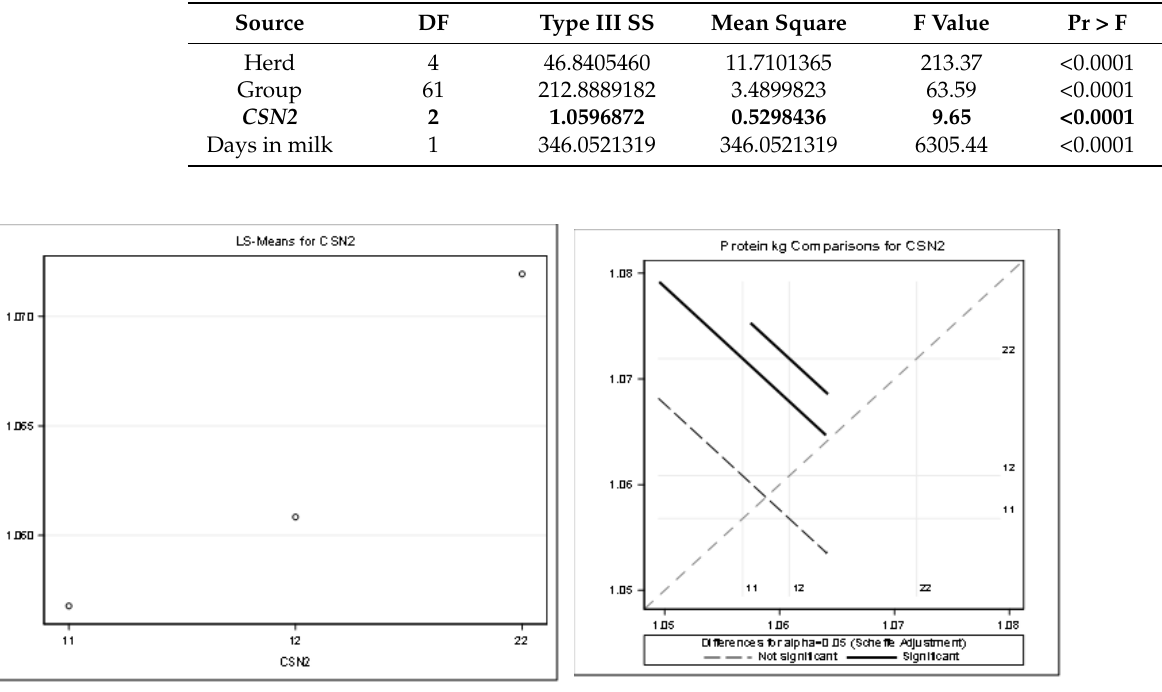
Table 13. Linear model (dependent variable: protein%). Source <0.0001 Figure 8. Least squares means and multiple comparisons for protein %. The statistically significant difference was found only between the genotypes A1A2 – A2A2. There was n statistically significant difference between the other genotypes.